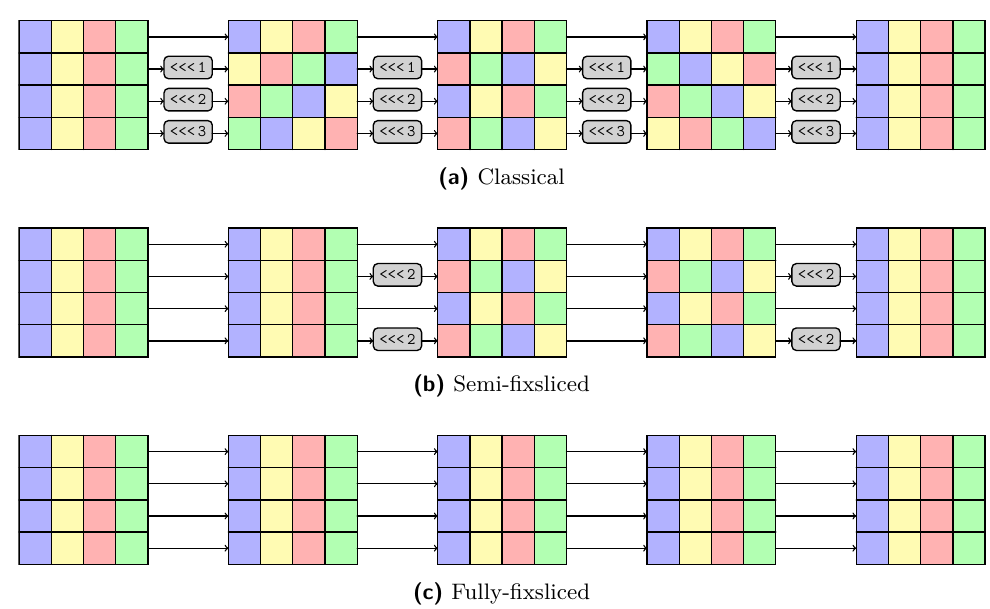
Figure 8: Overview of the AES internal state over 4 rounds according to different repre-